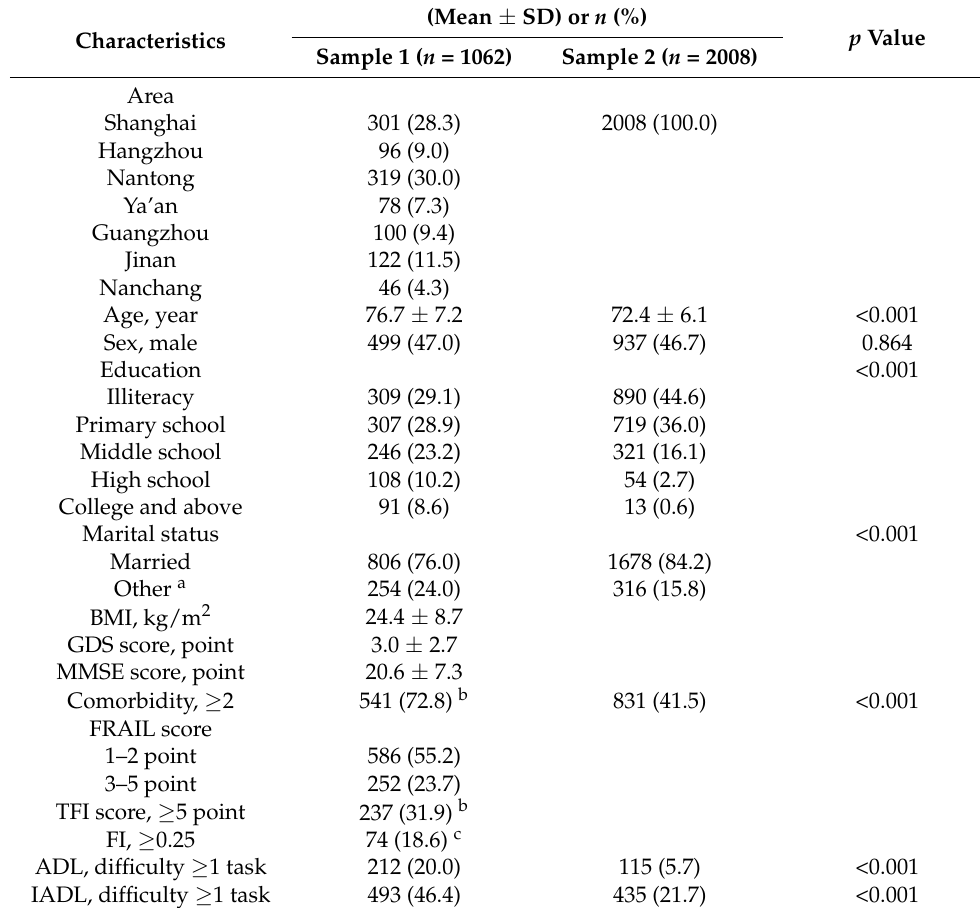
Table 1. Characteristics of sample 1 and sample